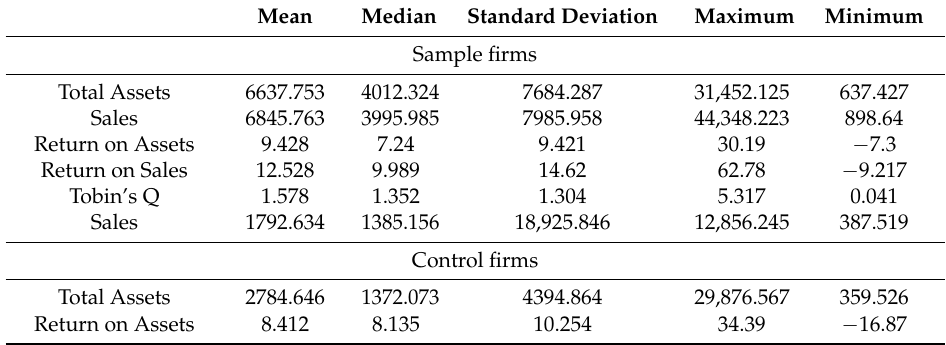
Table 1. Descriptive statistics for sample and control firms matched by ROA and size (year